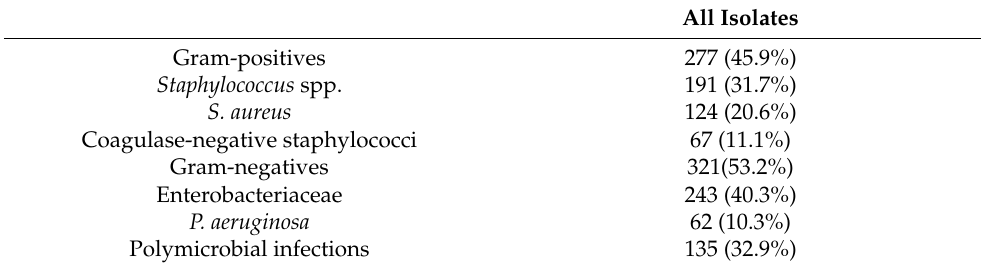
Table 1. Microbiological findings of the non-Cutibacterium